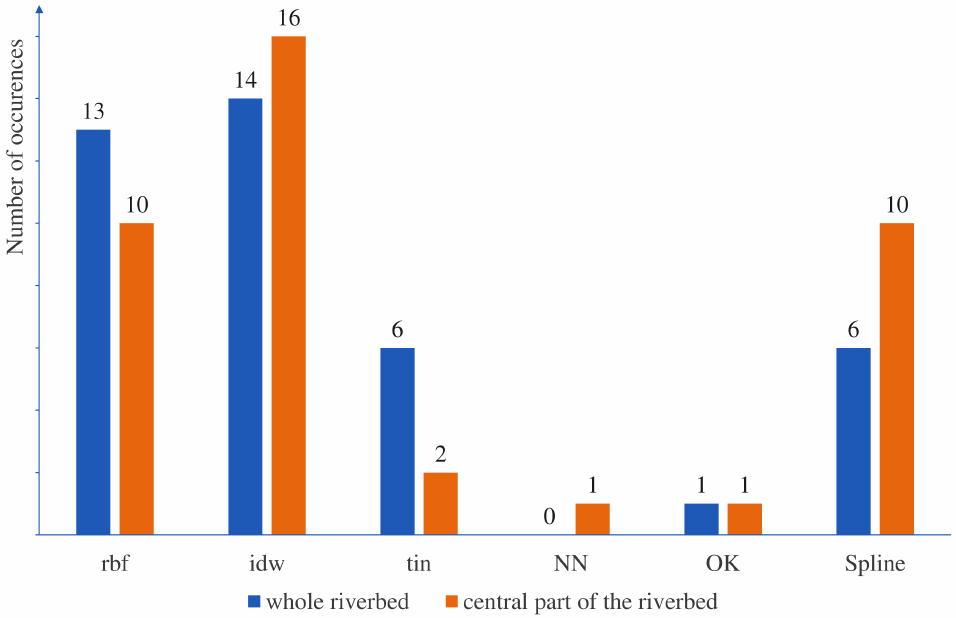
Figure 13. Number of occurrences of maximum error [m] in cross-sections estimated for the six interpolation